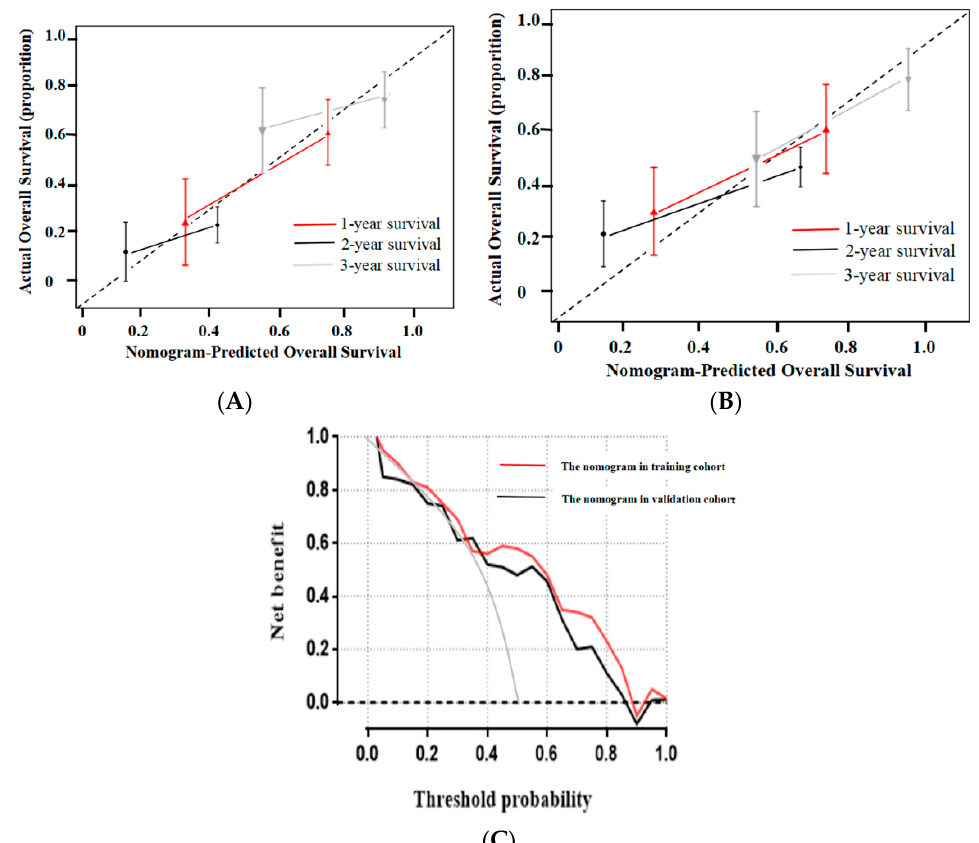
Figure 6. Calibration and decision curve analyses. ( A ): Calibration curves of the nomogram on the training dataset. The Hosmer–Lemeshow test yielded a p -value of 0.121 in the training dataset. ( B ): Calibration curves of the nomogram on the validation dataset. The Hosmer–Lemeshow test yielded a p -value of 0.137 in the validation dataset. ( C ): Decision curve analysis for the newly constructed nomogram (nomogram II) in the training cohort and the validation cohort. The y -axis represents the net benefit, and the x -axis represents the threshold probability. The newly constructed nomogram obtained more benefit than either the treat-all-patients scheme (gray line) or the treat-none scheme (horizontal black dashed line) within certain ranges of threshold probabilities for predicting therapeutic response to sequential cTACE in HCC.